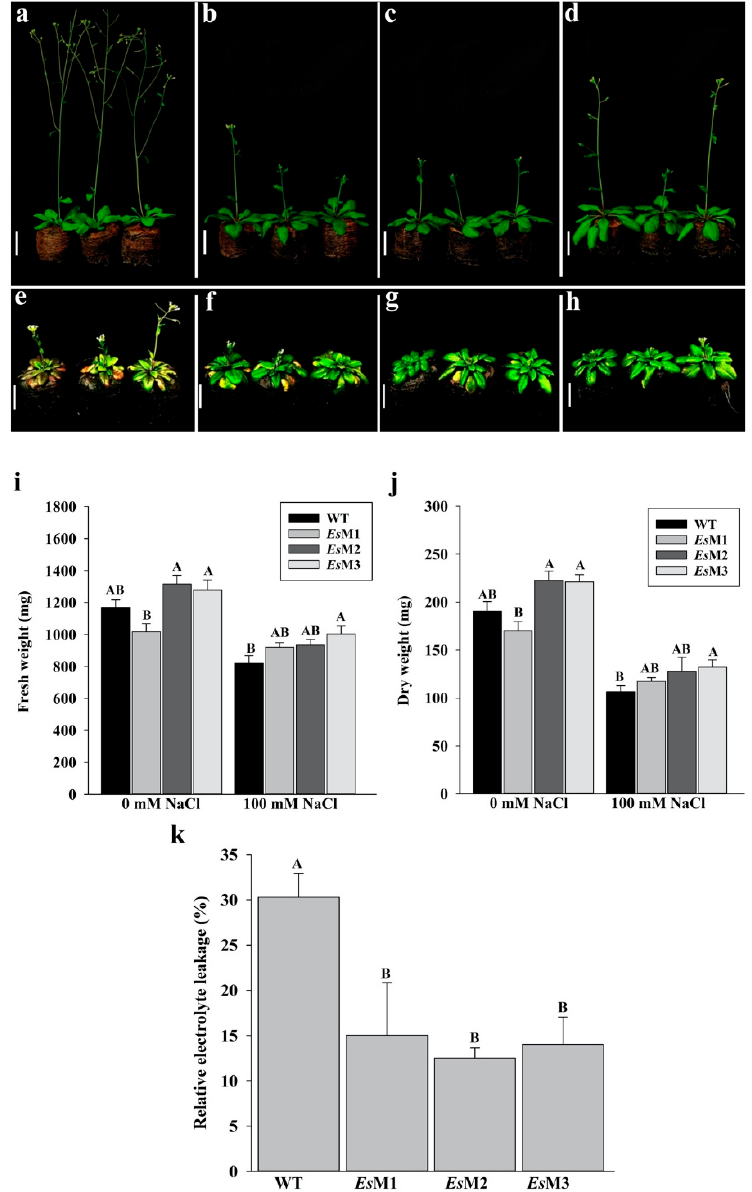
Figure 2. Plants growth, fresh weight (FW), dry weight (DW) and electrolyte leakage of the wild type and 3 independent transgenic lines ( Es M1, Es M2 and Es M3), grown in the absence and presence of 100 mM NaCl. Plants ( a – d ), were grown under standard conditions while in ( e – h ), plants were grown in the presence of 100 mM NaCl. The white bar indicates 3.5 cm. ( a , e ) WT, ( b , f ) Es M1, ( c , g ) Es M2 and ( d , h ) Es M3. The plants were photographed at 10 days after irrigation when they were 25 days old. ( i ) fresh weight, ( j ) dry weight and ( k ) electrolyte leakage. Columns represents the mean and the bars